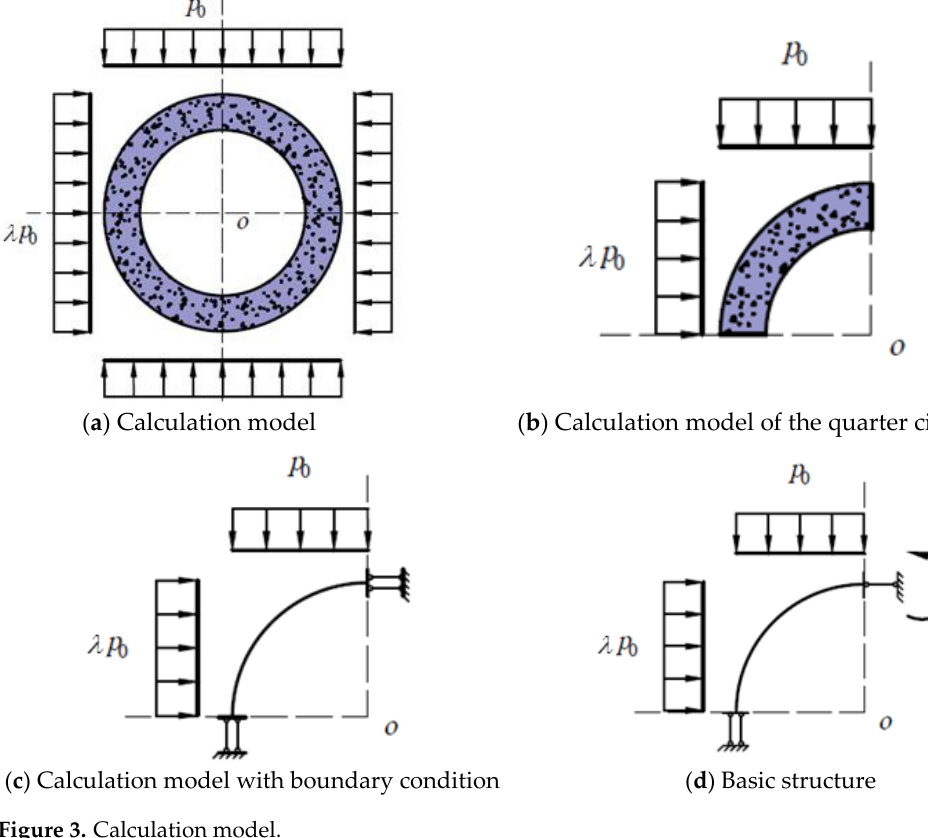
Figure 2. Microelement of the circular lining.